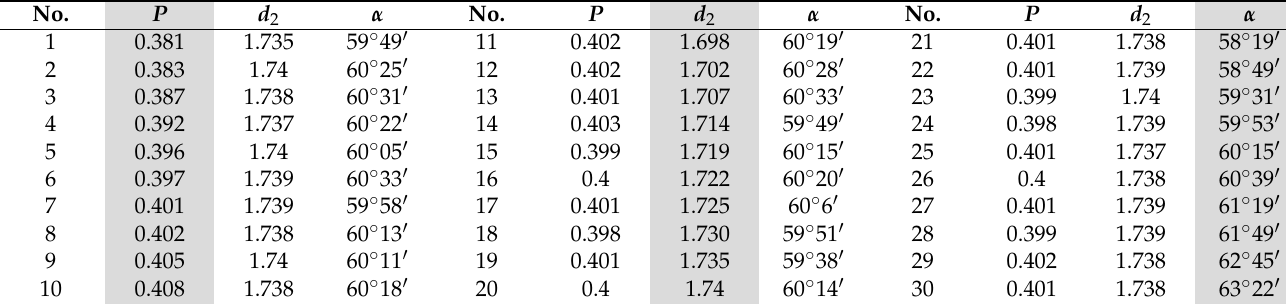
Table 3. Thread Test Piece Parameter